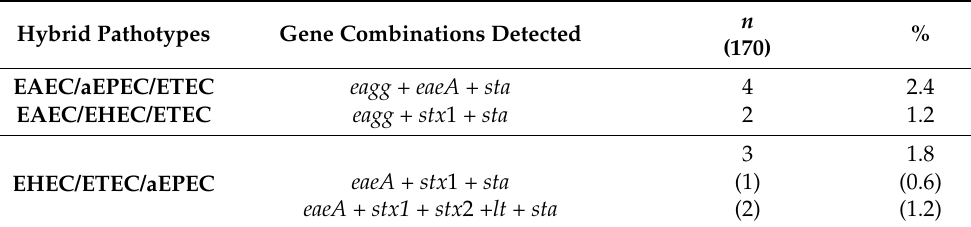
Table 4. Hybrid pathogenic type (three pathotypes) of E. coli and their virulence genes detected in this